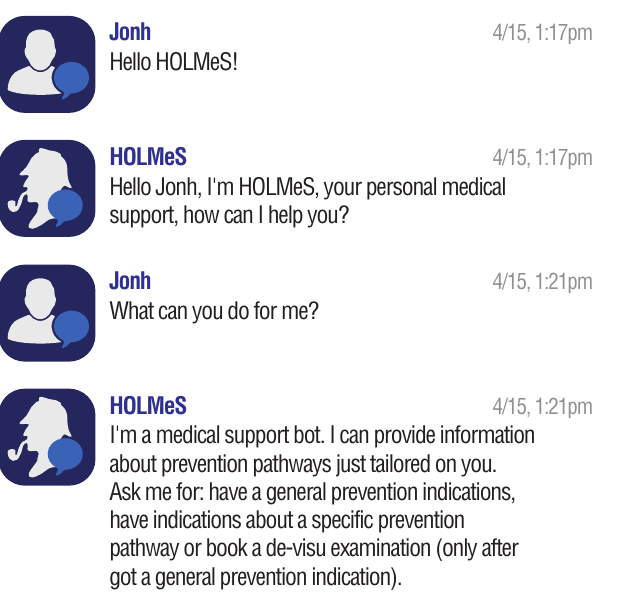
Figure 5. Conversing with HOLMeS: Greating